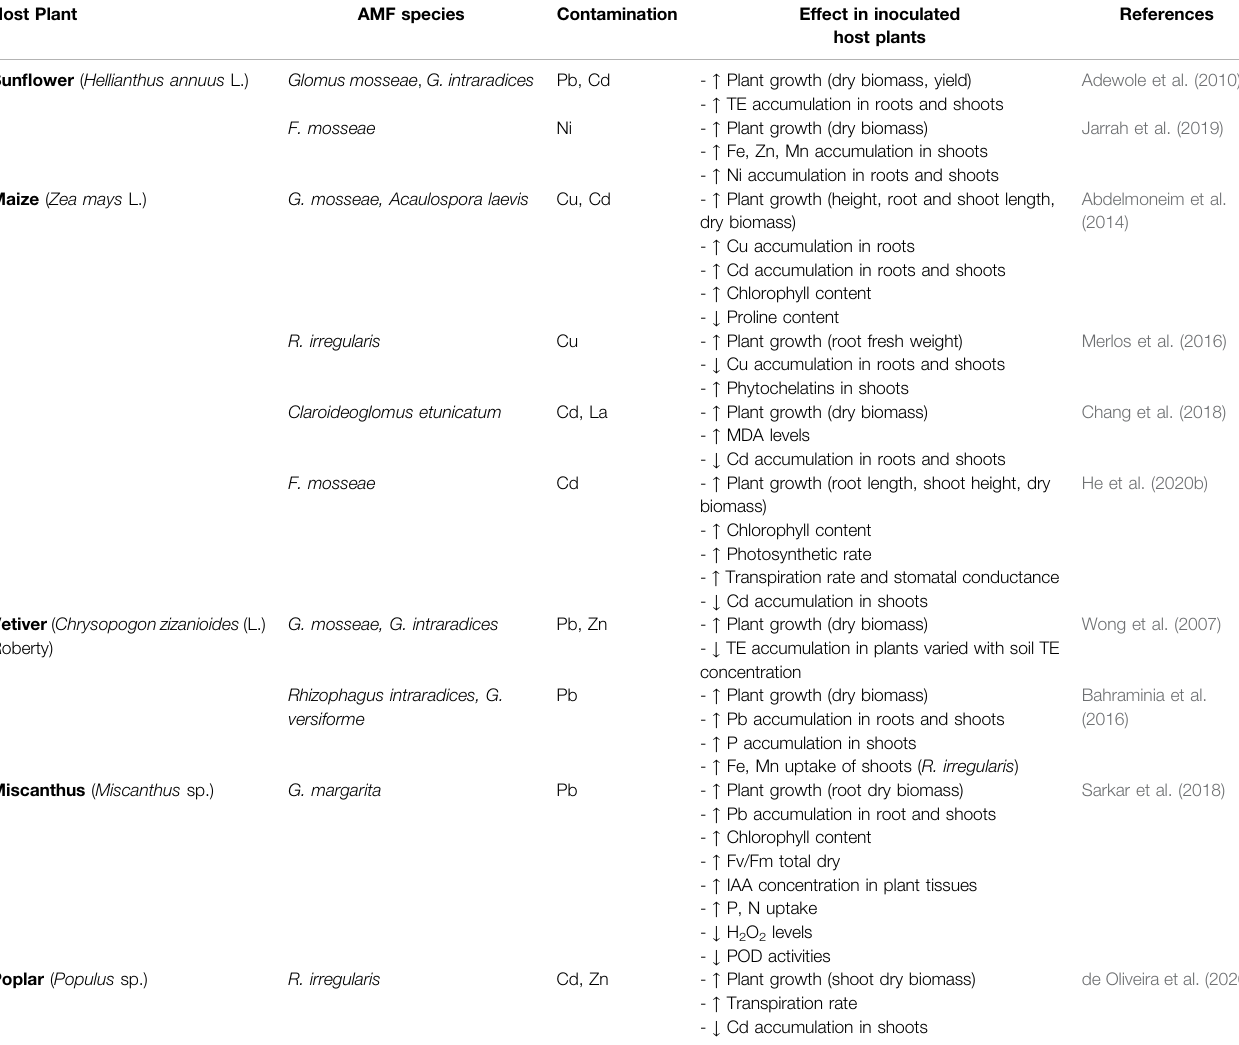
TABLE 6 | Effects of AMF inoculation on growth and development of economically valuable crops grown under TE-contamination. Host